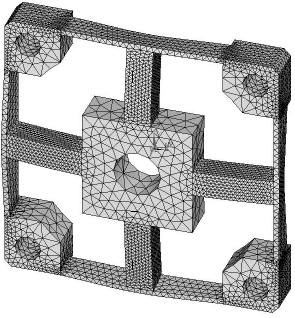
Figure 7. Mechanical model of an elastic body under F